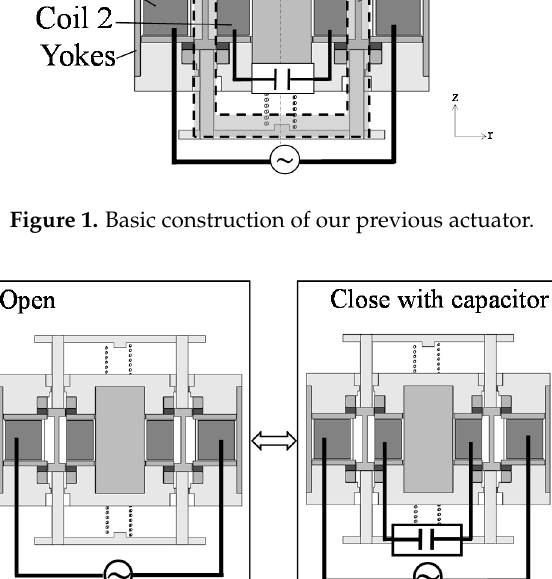
Figure 2. Connections of coils in previous actuator.